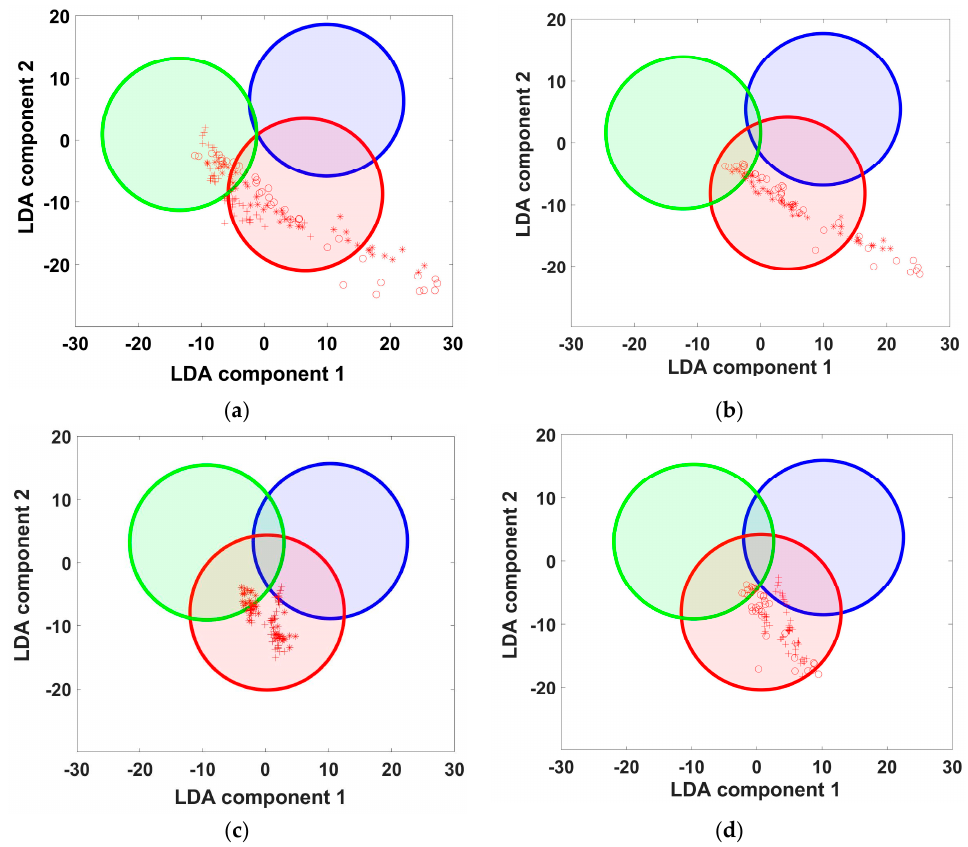
Figure 9. LDA diagrams illustrating e-nose recognition of three deviating exposures to analytes. ( a )-recognition with the LDA model built on the training pool which contains data of 35 previous exposures: the recognition score is 0.48. Inclusion of only one of the deviating e-nose data into the training pool of the LDA model radically improves the recognition of the two other deviating exposures: ( b – d ) show the three possible variants of the inclusions; the scores are 0.8 in ( b ) and 1.0 in ( c , d ).